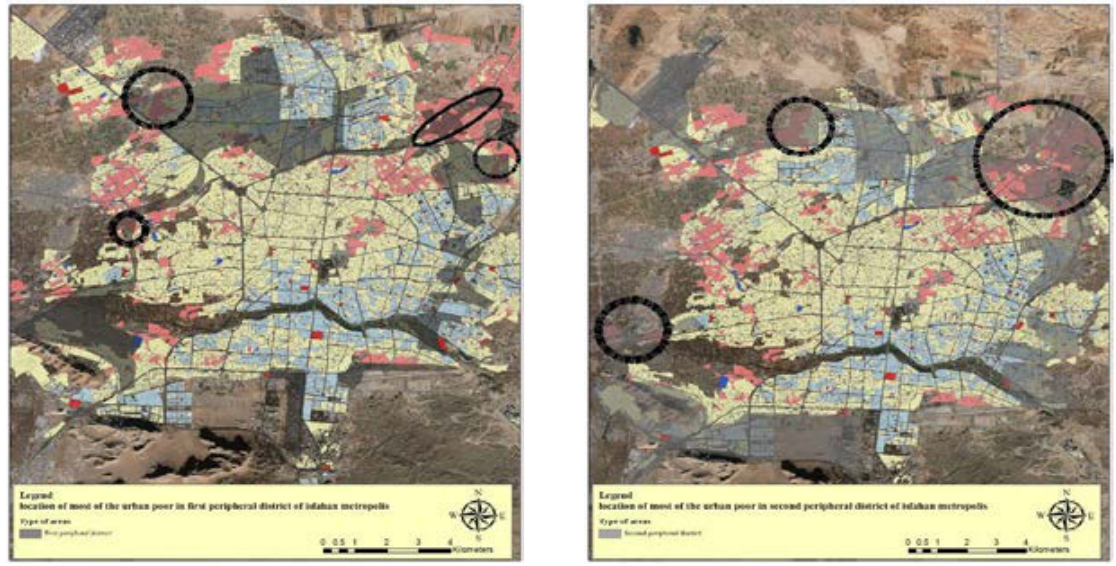
Fig. 12: The spatial concentrations of urban poor (UPRDS) in first peripheral district (a) and second peripheral district (b)